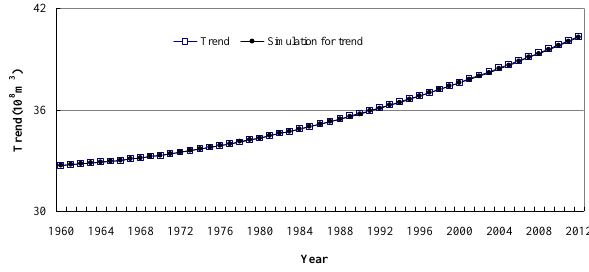
Figure 11. Simulation for the trend of AR by nonlinear regression equation.